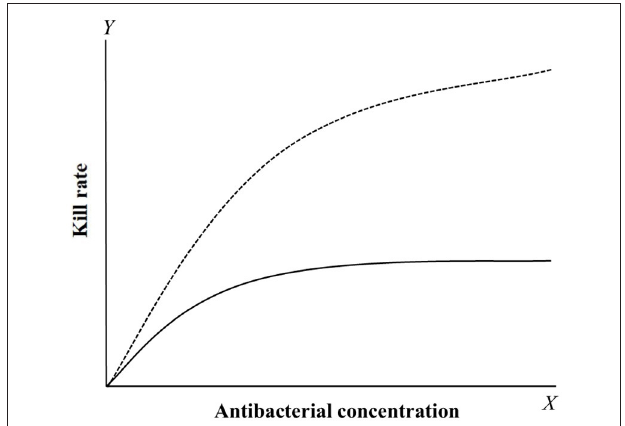
FIGURE 3 | The relationship curves between kill rate and concentration of concentration-dependent (dotted line) and time-dependent (solid line) drugs. For concentration-dependent drugs, the kill rate will gradually increase with the concentration added. For time-dependent drugs, the kill rate was smaller compared to concentration-dependent drugs and rapidly reach a plateau that the value have little change with the concentration